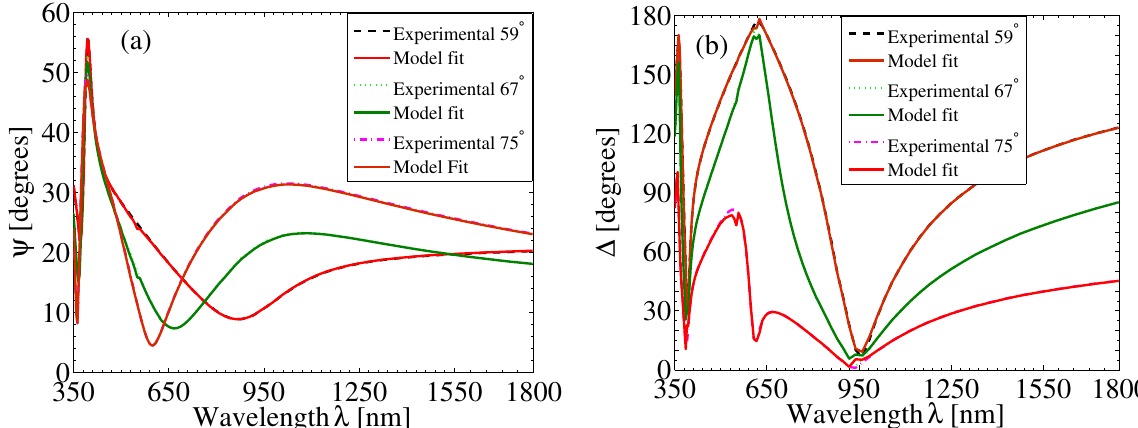
Figure 2. Spectral dependence of the measured ellipsometric data at room temperature: ( a ) Ψ and ( b ) ∆ for a bilayer with a 100 nm-thick ALD-TiO The data are fitted by the Cauchy model at three different angles (59 ◦ , 67 ◦ and 75 ◦ ).